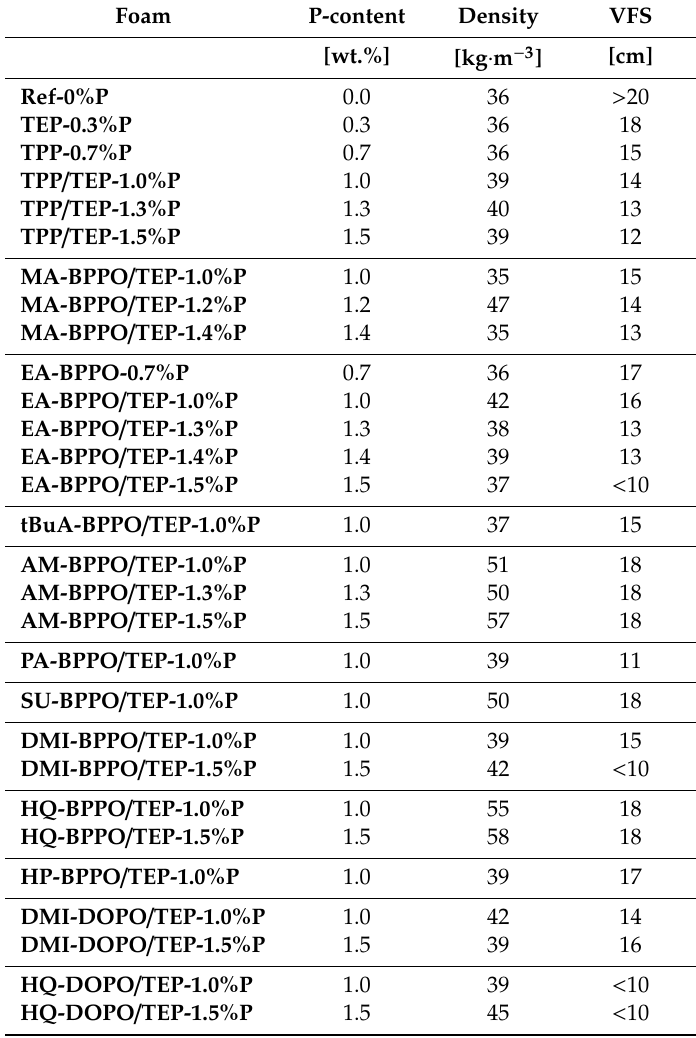
Table 6. Results of vertical flame spread vertical flame spread (VFS) test (DIN 4102).